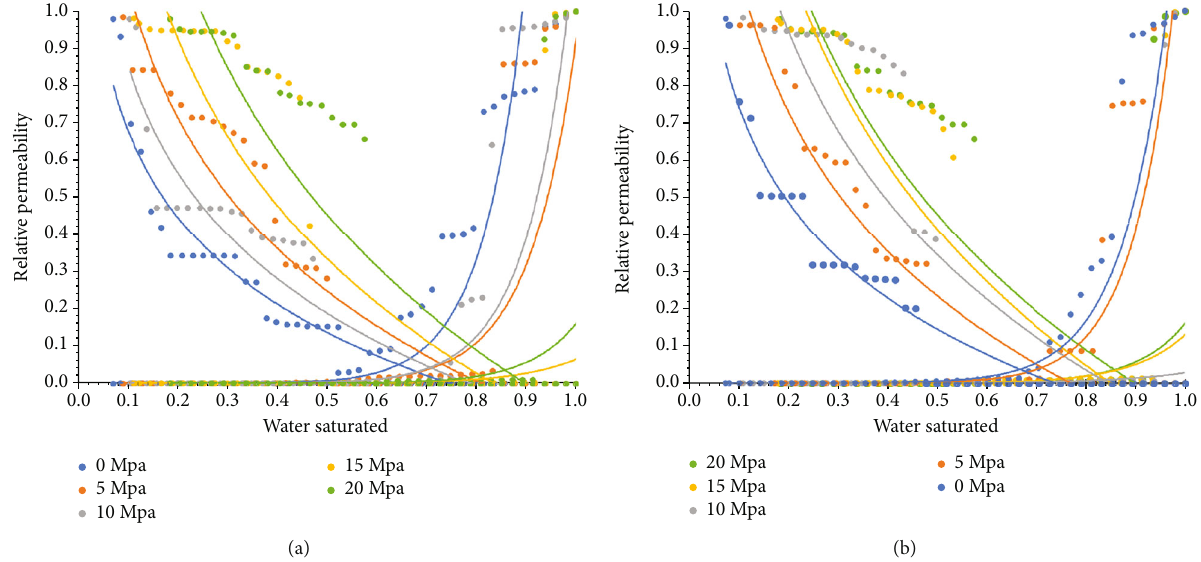
Figure 10: Gas-water relative permeability curves for fractured-porous carbonate rock through pore network model simulation. (a) Pressurized process and (b) depressurization process.